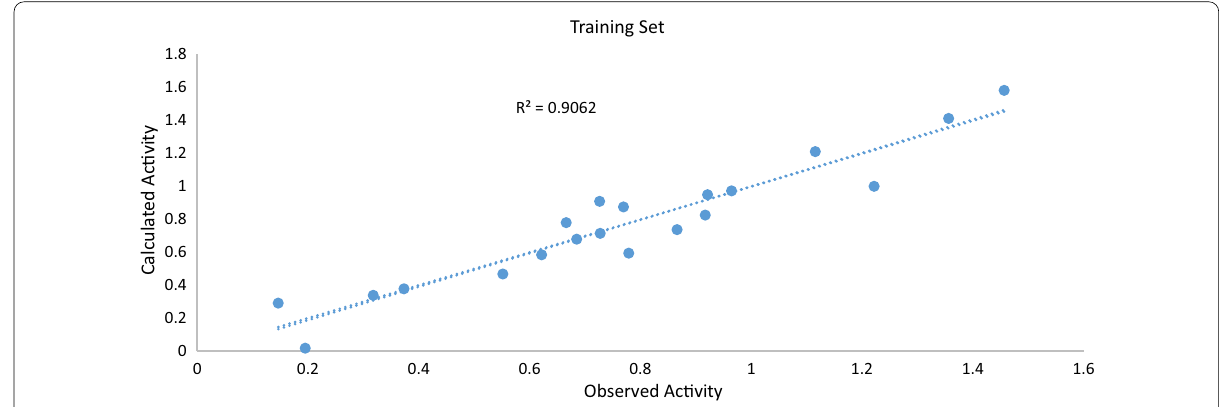
Fig. 2 Graph of calculated activity versus observed activity of training set